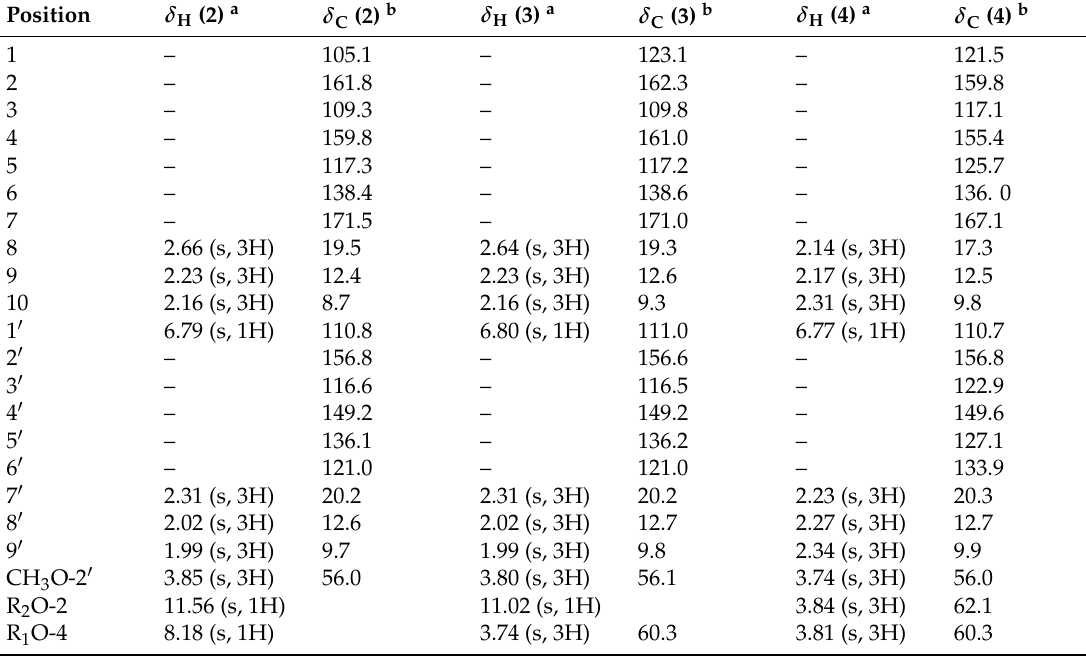
Table 2. Spectroscopic data of brialmontins III ( 2 ), I ( 3 ) and II ( 4 ) ( δ in ppm, recorded in acetone- d 6